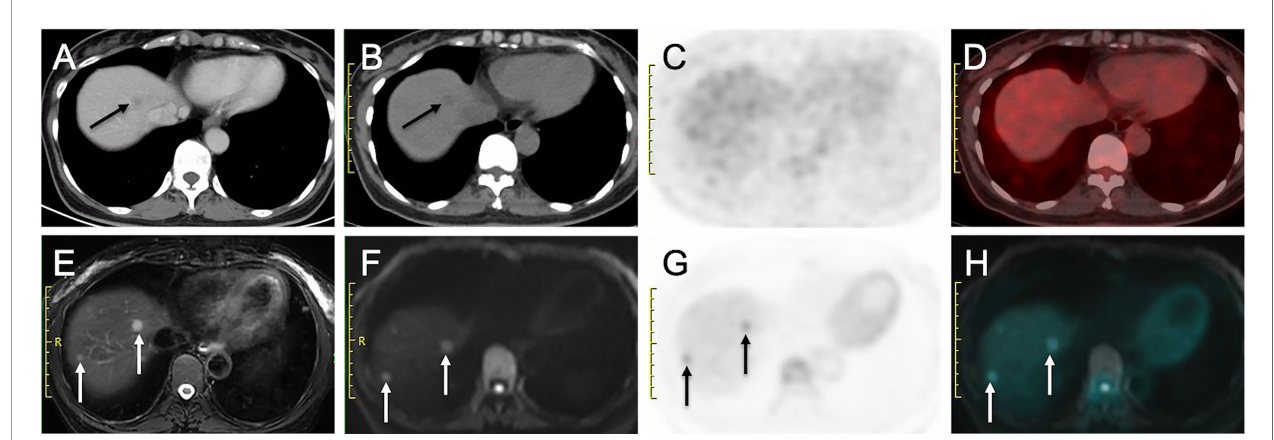
FIGURE 4 | More liver metastases detected on delayed PET/MRI than on CE-CT and early PET/CT. (A) Venous phase CT image shows a hypo-enhanced nodule in liver (arrow). (B) Nonenhanced CT image shows a hypoattenuating nodule in liver (arrow), (C) Early PET image and (D) Corresponding PET/CT fusion image show that the nodule does not show obvious hypermetabolism. (E) Fat-suppressed T2WI shows two hyperintense nodules in liver (arrows). (F) DW image (b = 800 sec/ mm2) shows two nodules with restricted diffusion (arrows). (G) Delayed PET image shows two hypermetabolic nodules in liver (arrows). (H) Corresponding PET and DW fusion image shows the two nodules with both hyperintense and hypermetabolism